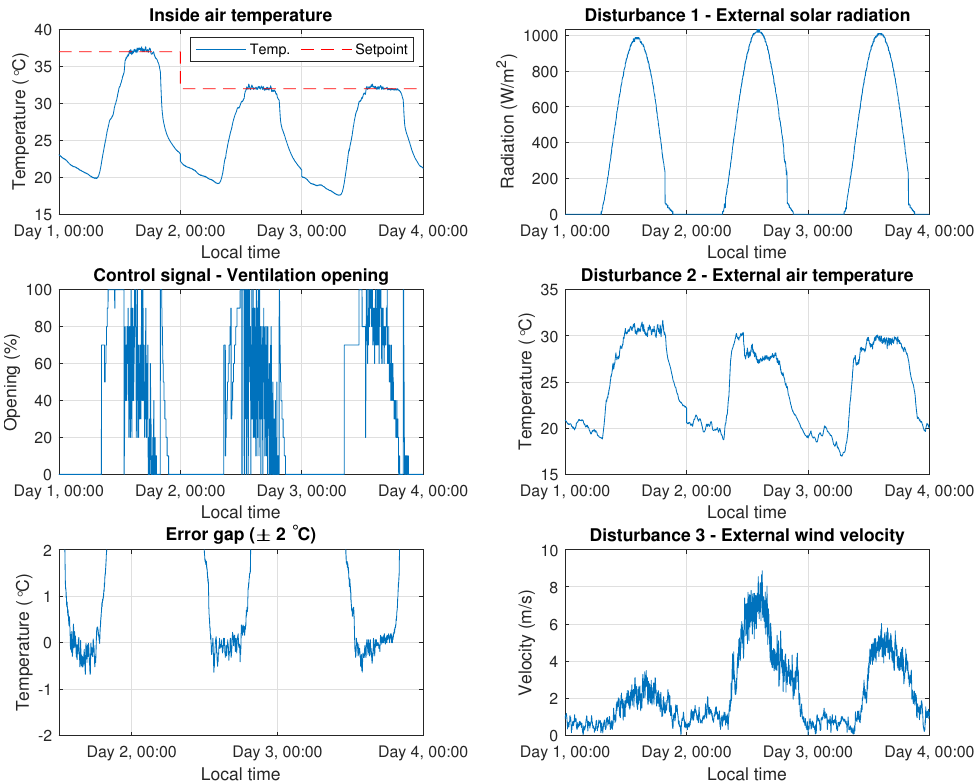
Figure 14. Real control tests performed at the experimental greenhouse.